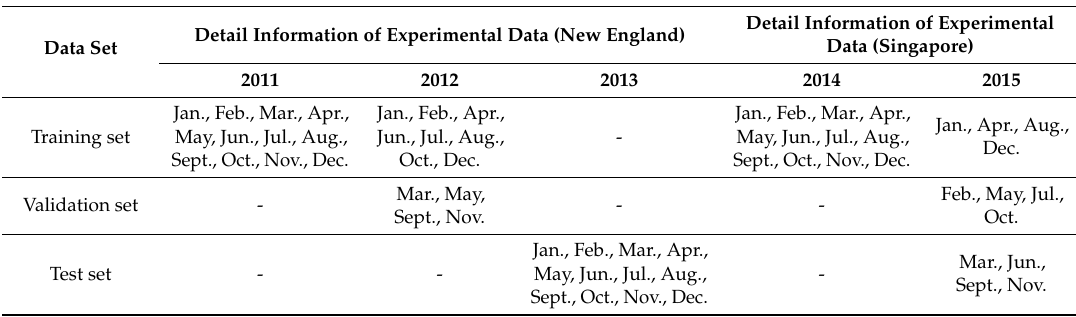
Table 2. Experimental data description.